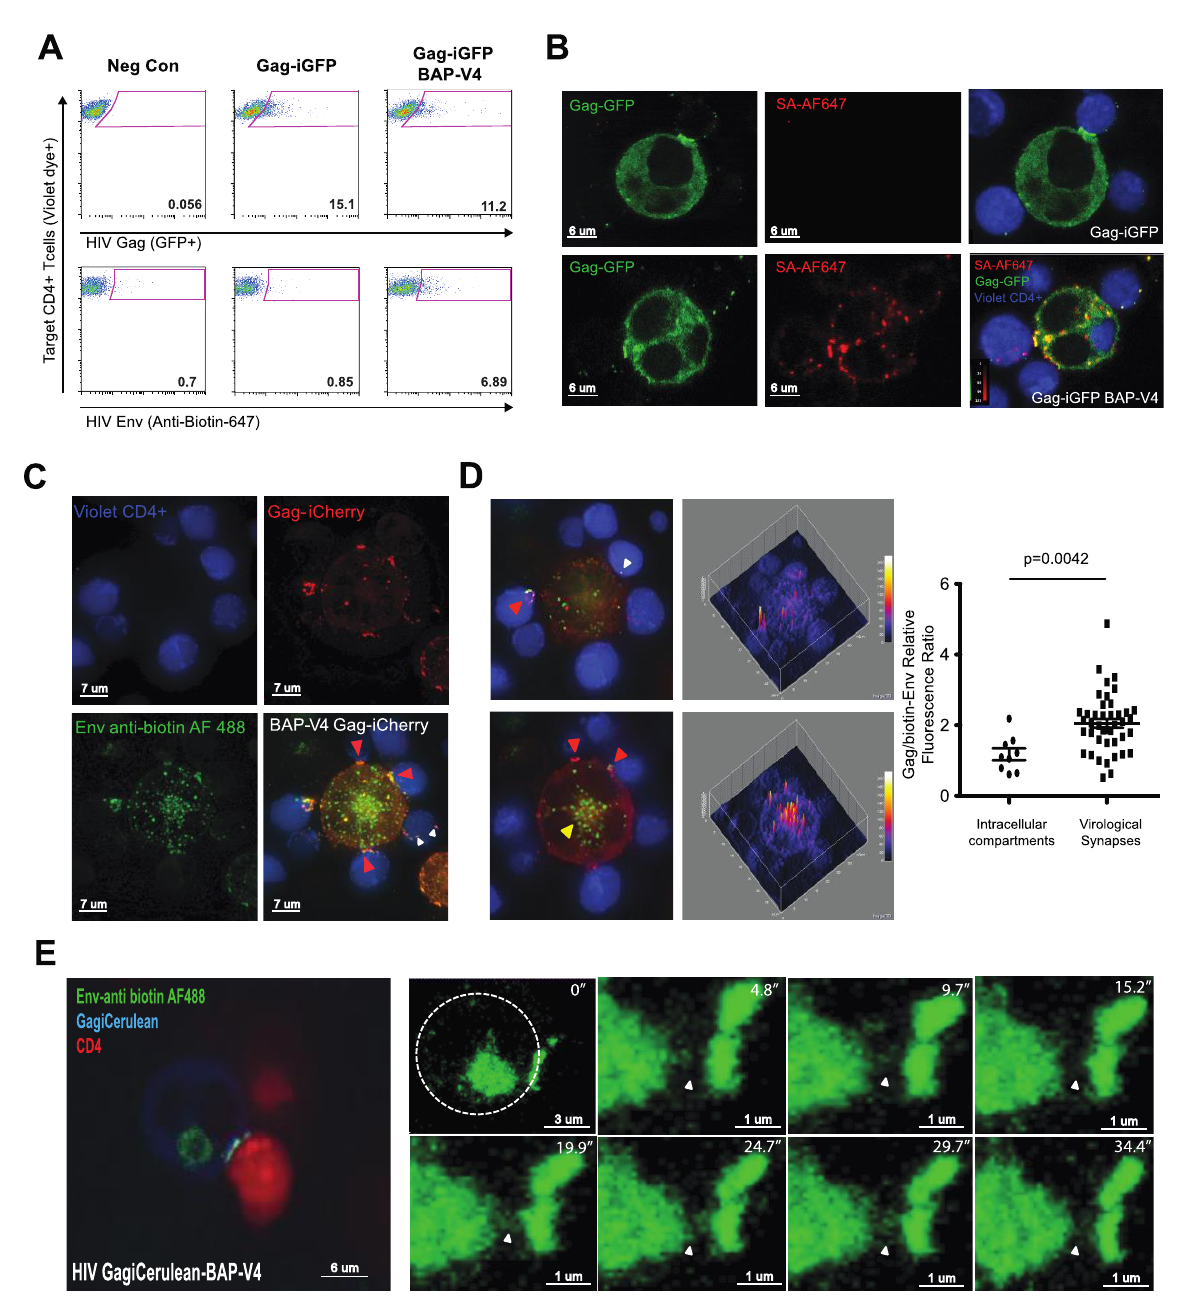
Figure 3. Simultaneous visualization of HIV Gag and BAP-V4 Env during virological synapse formation and cell–cell transfer. J-BirA cells infected with HIV Gag-iGFP or Gag-iGFP-BAP-V4 were used as donor cells in 4 h cell–cell transfer assays with primary CD4 T cells (Violet dye+; Alexa 405). ( A ) Flow cytometry dot plots show the levels of HIV Gag (GFP+; top row) and biotinylated Env (anti-Biotin-647; bottom row) transfer into target cells after 4 h transfer assays. ( B ) Laser scanning confocal image analysis of HIV-1 cell–cell transfer between Jurkat + BirA cells infected with Gag-iGFP (top row) or Gag-iGFP-BAP-V4 (bottom row) and uninfected primary CD4+ T cells (Violet+), with streptavidin Alexa Fluor 647 used to detect biotin. Left column shows localization of Gag-GFP. Middle column shows localization of Env (anti-Biotin-647). Far righthand column shows merged co-localization of Gag and Env at VSs. ( C ) Higher-resolution maximum-intensity projection images of Gag and Env co-localization in infected donor–target conjugates were generated using deconvolution microscopy performed on 20 medial z-stacks. Red arrowheads indicate the co-localization of Gag (mCherry) and Env (Alexa Fluor 488) at VSs. White arrowheads represent the transfer of Gag and Env into the target CD4 T cells. Ratio of Gag/Env fluorescence intensity (not reflective of molar ratio) was measured in intracellular compartments ( n = 9) as compared to VSs ( n = 43). ( D ) Representative image analysis of deconvolved images (left column) for quantifying the 3D intensity profiles of Gag and Env across z-stacks (right column), in order to compare the biotin-Env/Gag relative fluores- cence ratio within intracellular compartments vs. at the VS. The yellow arrowhead represents intracellular compartments containing Env. Red arrowheads indicate the co-localization of Gag and Env at the VS. Graph displaying the Gag-to-Env